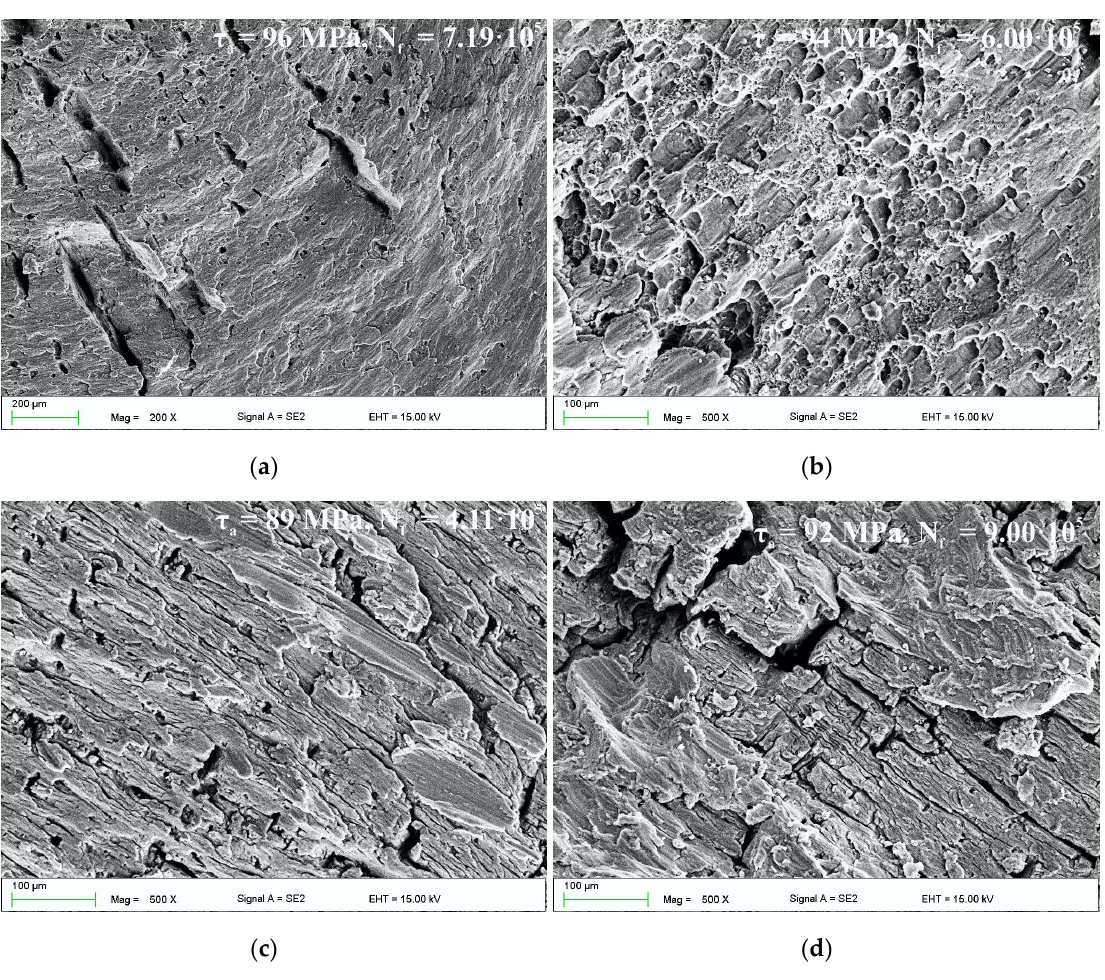
Figure 13. Fractures of fatigue test samples (double-sided torsion) of AlZn6Mg0.8Zr alloy, subjected to LTMP with 30% degree of deformation: ( a ) transcrystalline quasi-cleavage fracture with secondary cracks; ( b ) craters with diversified size on the fracture surface; ( c ) secondary cracks systems on the fatigue fracture surface of investigated alloy; ( d ) secondary cracks of deep depth on the fracture surface.